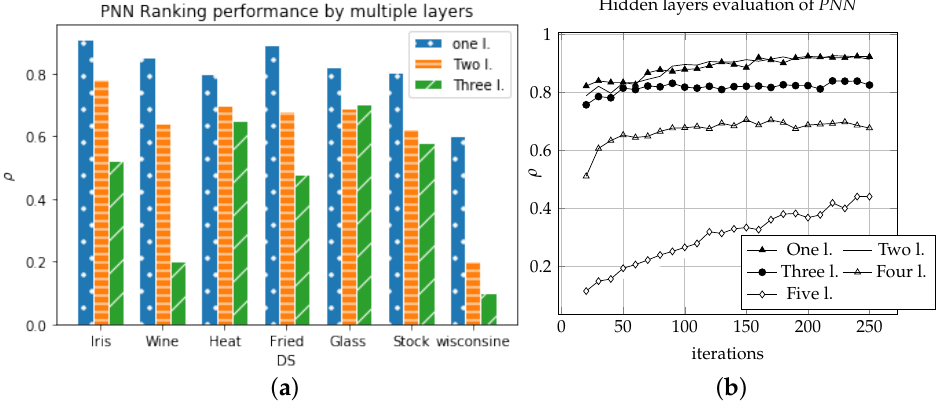
Figure 4. The Number of hidden layers comparison using PNN and SS . ( a ) Ranking using benchmark datasets [26]. ( b ) Convergence of Average ranking ρ of iris and wine in 200 epochs.